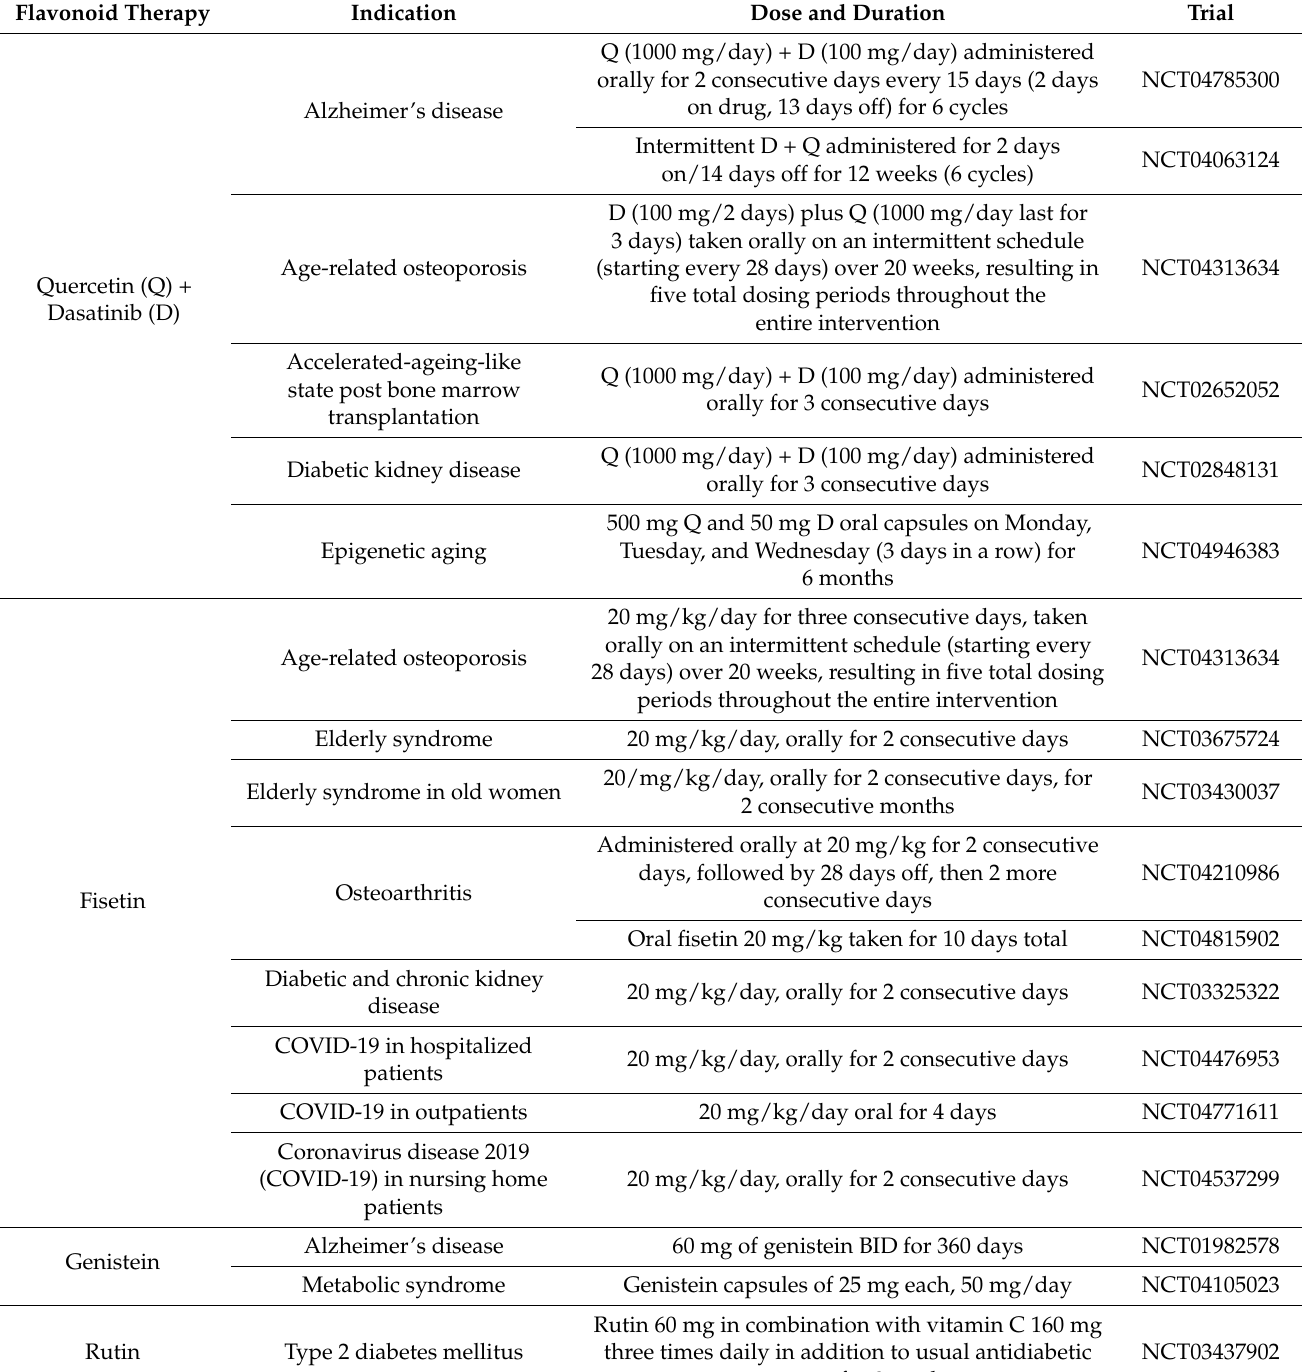
Table 2. Human clinical trials focusing on